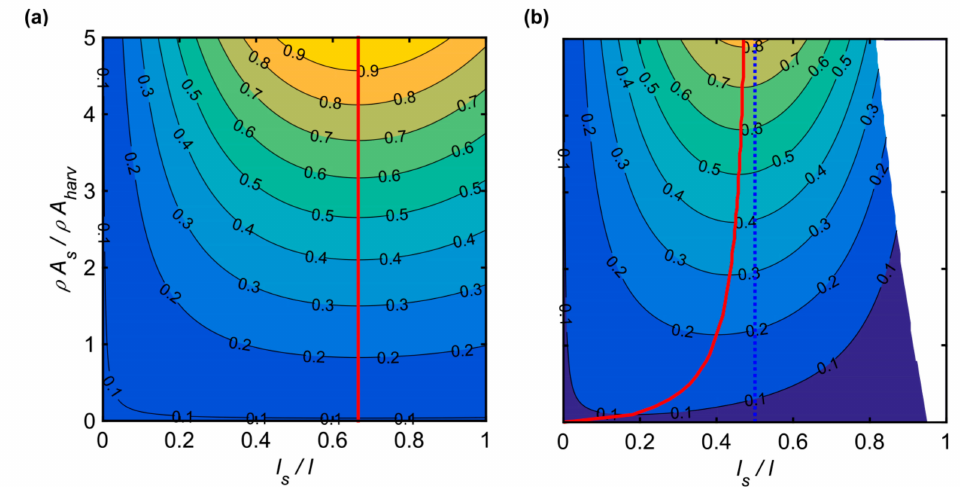
Figure 9. E ff ect of varying the configuration of solar panels on normalized PVDF peak power output. ( a ) Equivalent concentrated tip mass model. ( b ) Distributed tip mass model. Red line represents locus of maximum PVDF peak power for a given tip mass ratio. Blue dashed line in ( b ) represents an asymptote for maximum PVDF peak power as tip mass ratio increases significantly. Normalization is achieved through dividing contour values by the maximum value of both